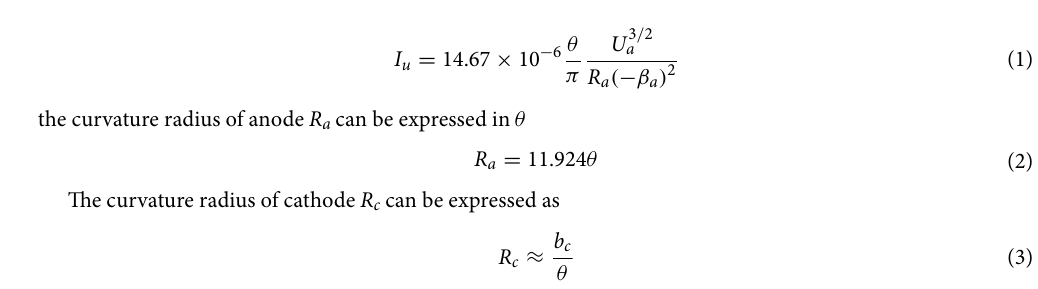
the curvature radius of anode R a can be expressed in θ